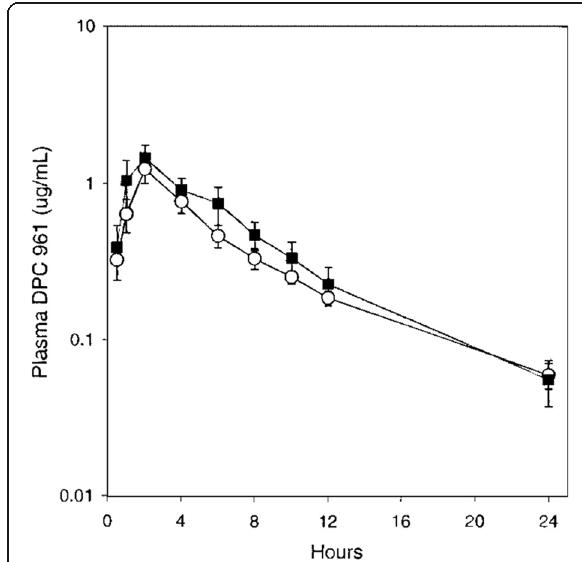
Fig. 7 Comparison of DPC 961 oral absorption in dogs administered 100 mg tablet formulations prepared with polymorph form I ( ○ ) or form III ( ■ ). (used with permission from Ref (Aungst et al.